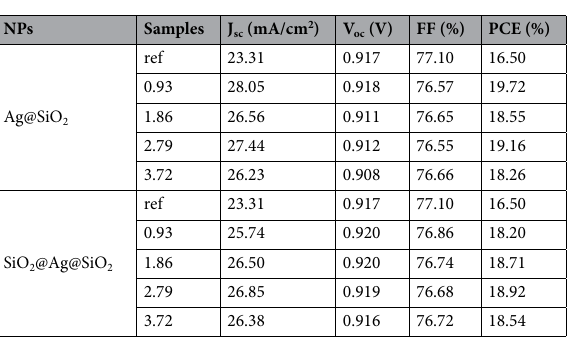
Figure 3. J-V characteristics of the incorporated planar devices with the different mass ratios of ( a ) Ag@SiO 2 and ( b ) SiO 2 @Ag@SiO 2 nanospheres. ( c ) J–V characteristics of the device incorporated with a 0.93% mass ratio of Ag@SiO 2 NPs in the presence (p-w meso) and absence (p-w/o meso) of mesoporous TiO 2 . NPs